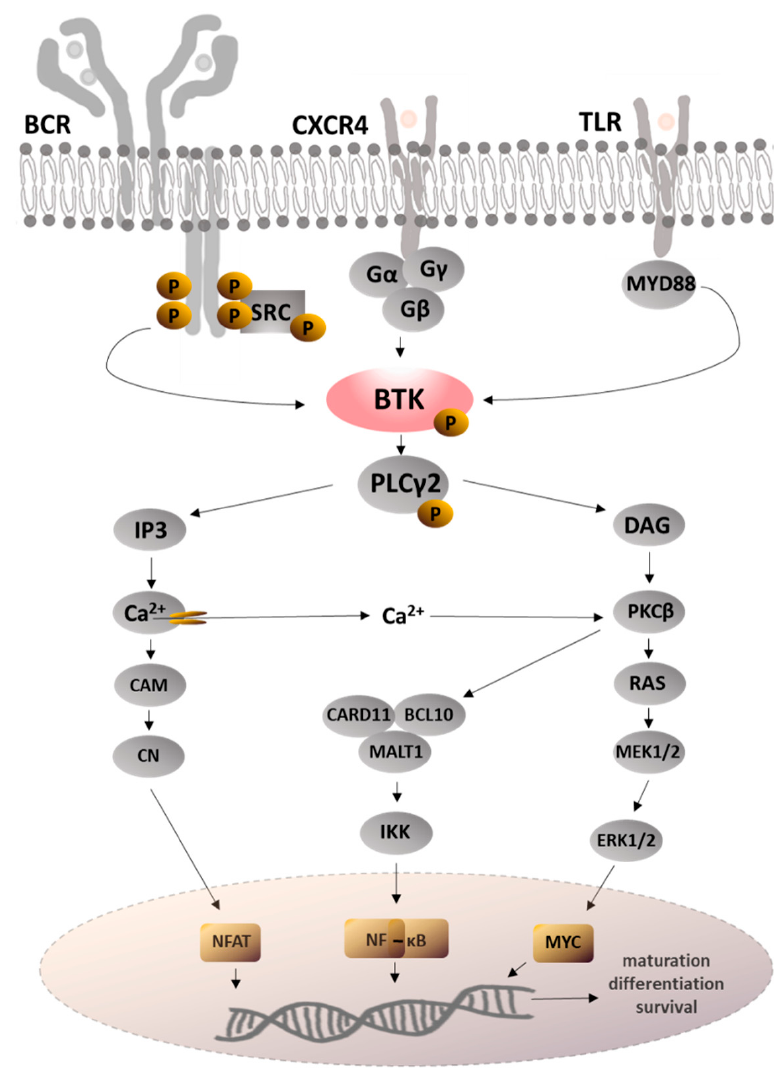
Figure 3. BTK pathway. BCL10—B-cell lymphoma/leukemia 10 protein, BCR—B cell receptor, CAM—calmodulin, CARD11—caspase recruitment domain-containing protein 11, CN—calcineurin, CXCR4—chemokine receptor type 4, DAG—diacylglycerol, ERK1/2—extracellular signal-regu- lated protein kinase ½, IKK—inhibitor of NF- κ B kinase, IP3—inositol 1,4,5-trisphosphate, MALT1—